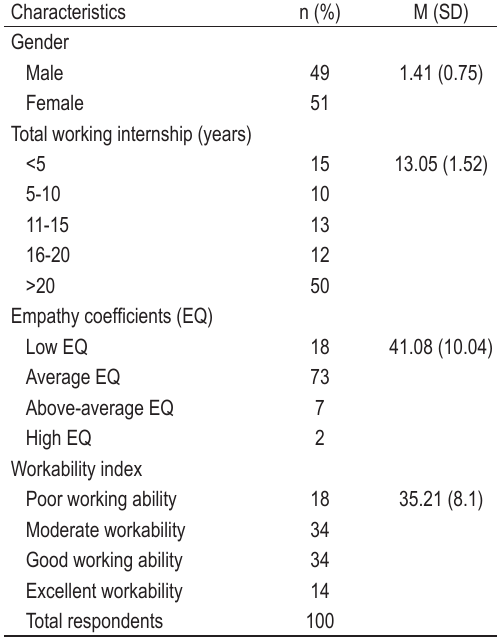
TABLE 1. Descriptive characteristics of